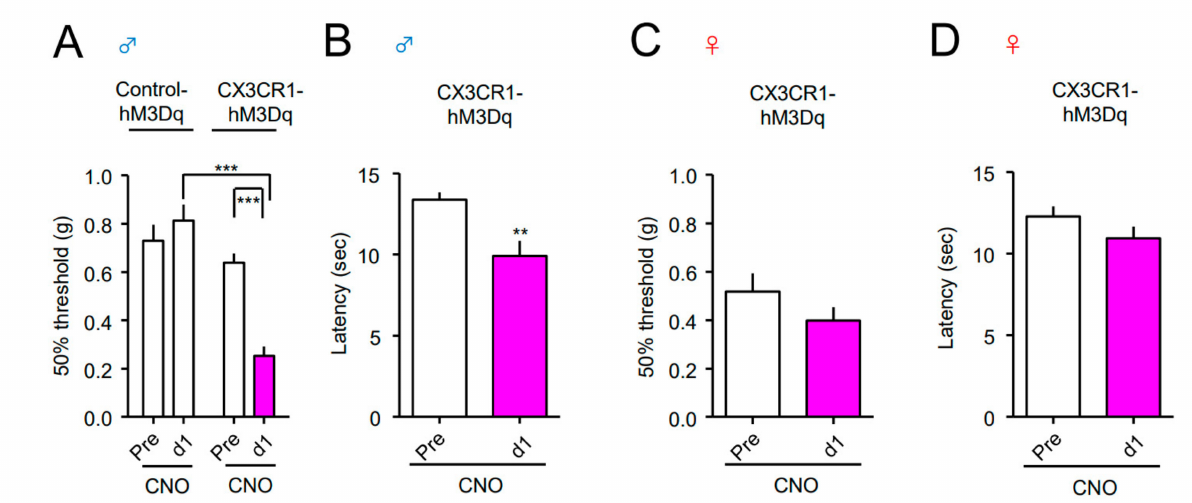
Figure 3. Induction of mechanical allodynia and thermal hyperalgesia by systemic CNO in male CX3CR1-hM3Dq mice. CNO (1 mg/kg) was intraperitoneally (i.p.) administered to naïve Control-hM3Dq and CX3CR1-hM3Dq mice of both sexes ( A , B ; male, C , D ; female). The 50% paw withdrawal threshold ( A , C ) or withdrawal latency ( B , D ) was assessed by the von Frey test or the Hargreaves test, respectively, before and one day after administration. Data are presented as mean ± SEM. ( A ) n =10 − 14. ( B ) n = 12. ( C ) n = 6. ( D ) n = 11. ***, p < 0.001; **, p <